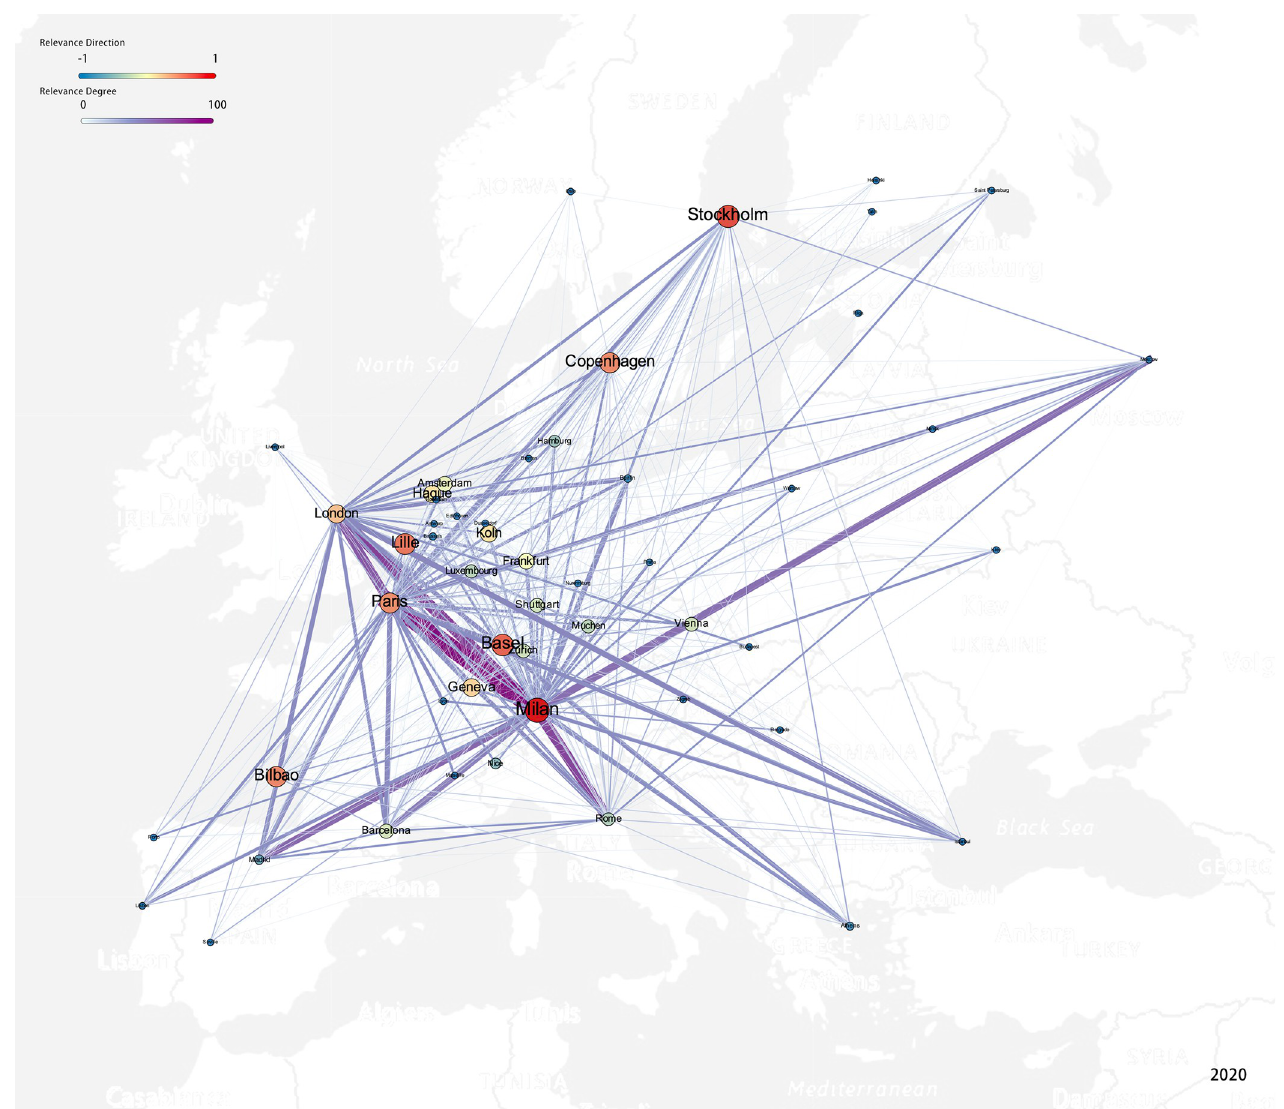
Fig 7. Creative industries’ interlocking network with the direction of interlocking. (Base map source: USGS National Map Viewer (public domain)).